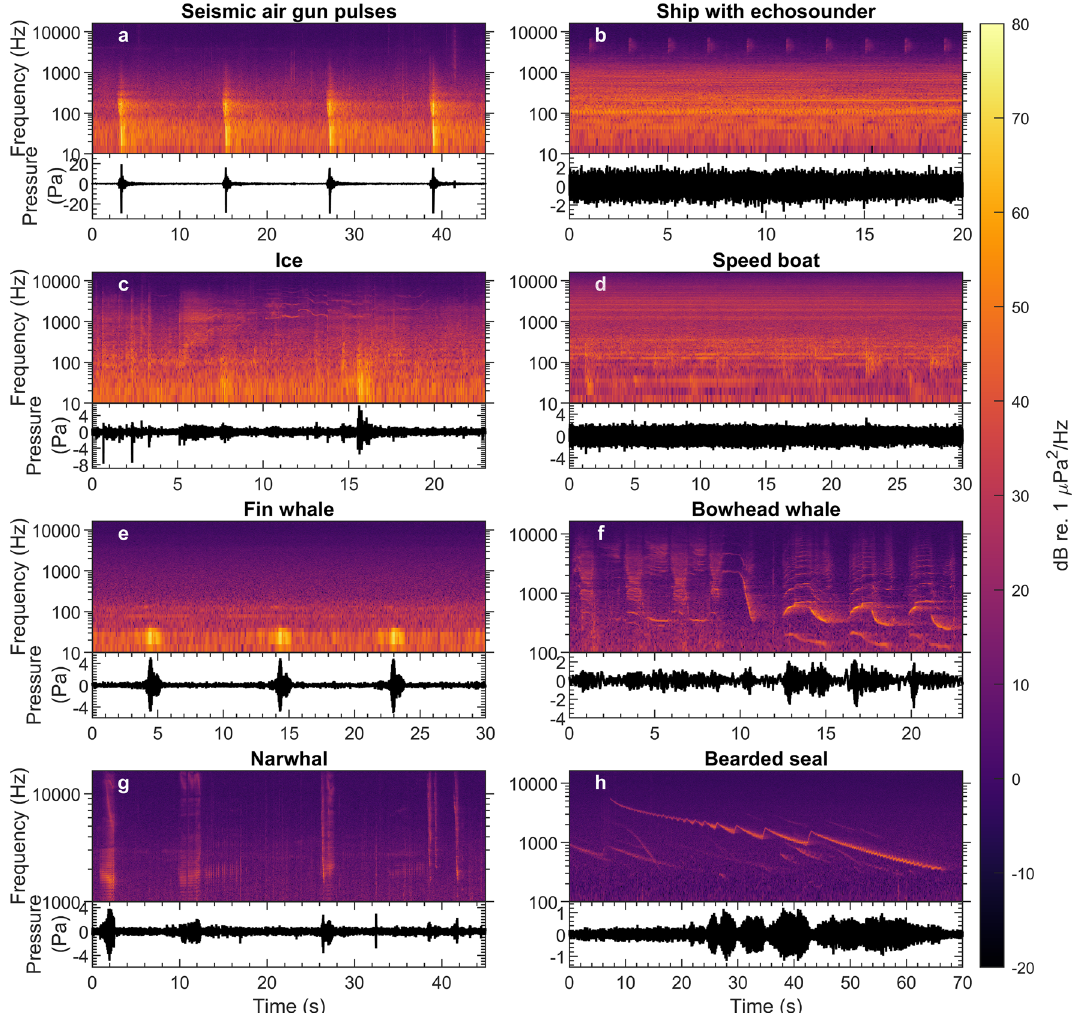
Figure 3. Sound source examples illustrating frequency contours and waveforms. ( a ) Seismic survey pulses (station 23). ( b ) Ship with active echosounder (station 21). ( c ) Ice noise showing both transient and tonal signals (station 21). ( d ) Speed boat (station 18). ( e ) Fin whale calls (station 25). ( f ) Bowhead whale calls (station 26). ( g ) Narwhal echolocation clicks and calls (station 26). ( h ) Bearded seal call showing the characteristically down-sweeping frequency contour of this species (station 21). All sources are recorded at unknown range. All signals were sampled at 32,768 Hz and spectrograms were made using an FFT size of 4096, a 4096-sample Hann window and a 2048 sample overlap. Note the logarithmic y-axes, which allow for better visualisation of low- frequency energy in the